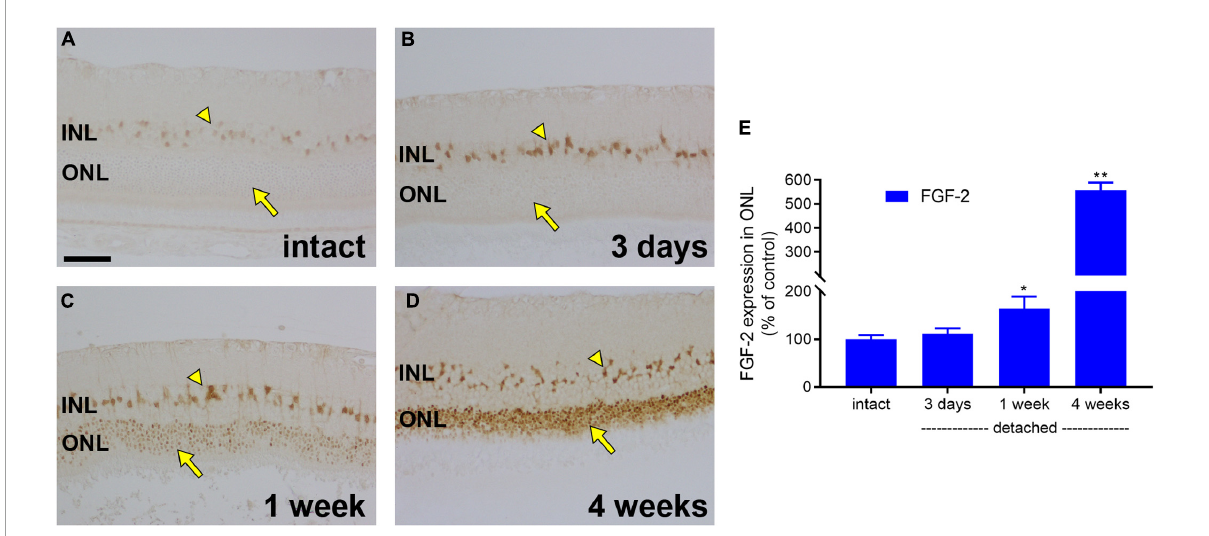
FIGURE8 Retinal detachment causes induction of FGF-2 expression in detached photoreceptors. (A–D) Representative images of FGF-2 immunolabelling in intact retina, and at 3 days, 1 week, and 4 weeks after detachment. Arrowhead highlights Müller cell somas; arrow demarcates photoreceptor cell bodies. Scale bar: 60 µ m. (E) Quantification of FGF-2 immunoreactivity within the outer nuclear layer (ONL) at 3 days, 1 week, and 4 weeks after retinal detachment. Values, shown as % of the intact group, represent mean ± SEM. * P < 0.05, ** P < 0.01 by Student’s unpaired t -test followed by modified Bonferroni correction (intact vs. detached). INL, inner nuclear layer.